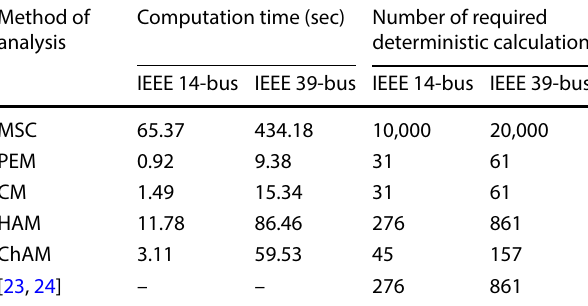
Fig. 9 a Cumulative distribution function, and b Probability distribution function of the real part of the mode#2 eigenvalue of the 9th gen- erator ( 𝜆 2, G 9 ) , in IEEE 14-bus system Table 4 The computational efficiency of different